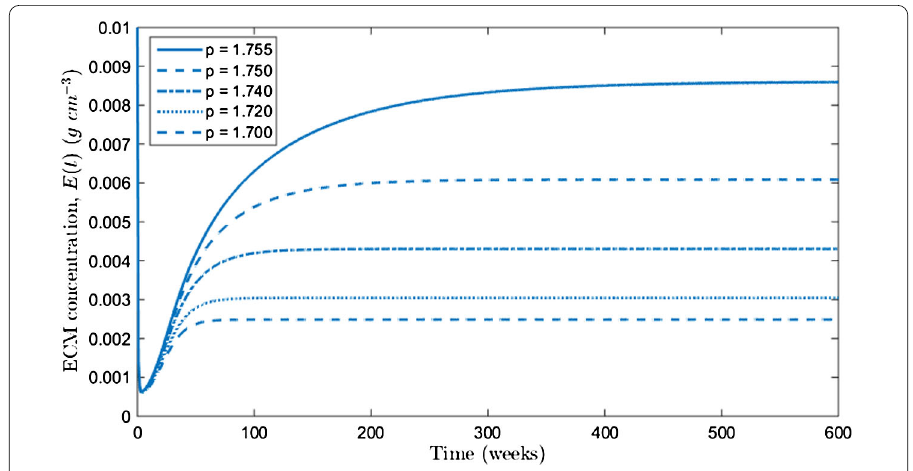
Figure 3 Simulated time courses of ECM concentration with the parametric values given in Table 2 and 1.7 ≤ p ≤